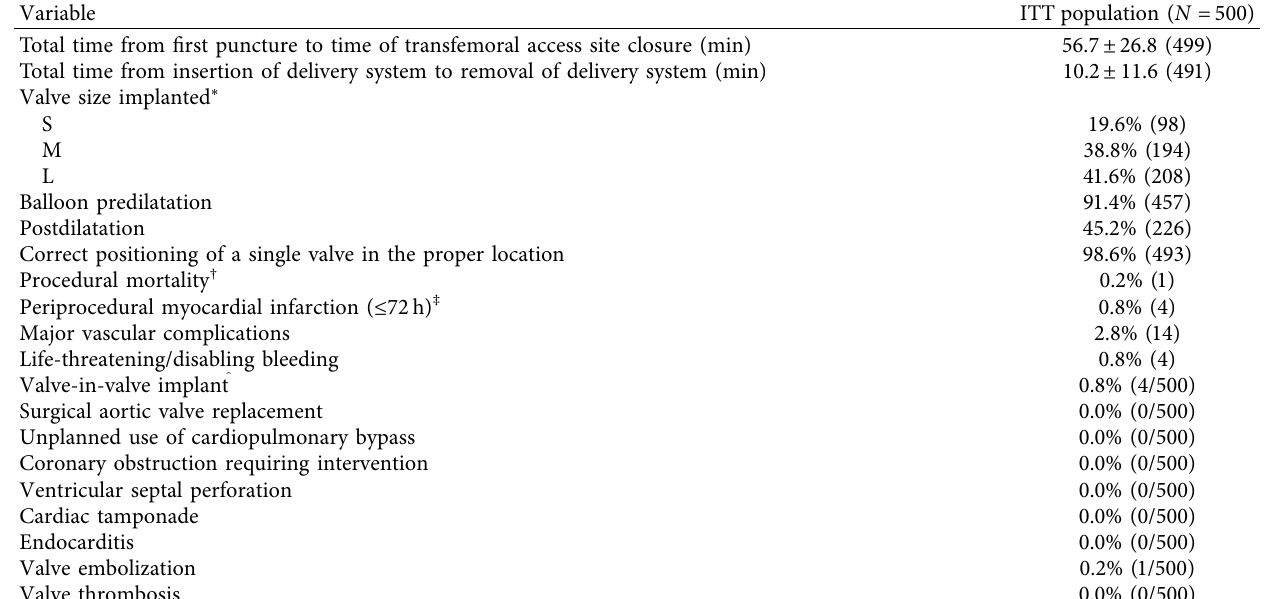
Table 1: Procedural